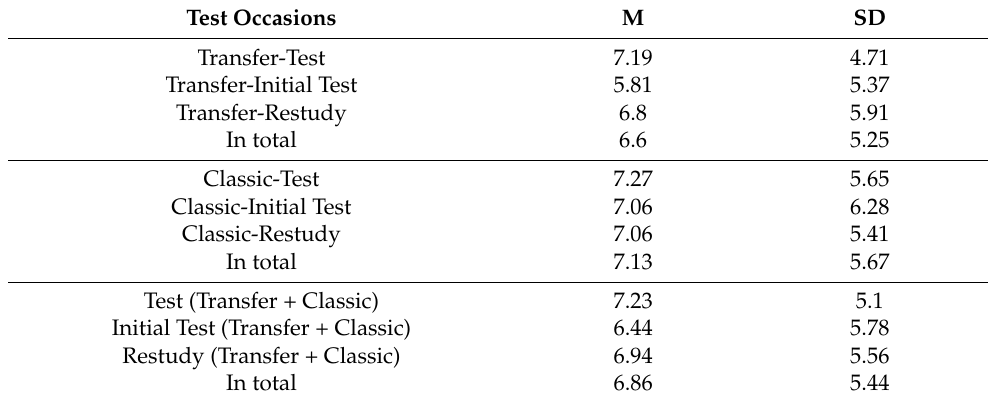
Table 2. Means and standard deviations over the number of correct responses in the cumulative